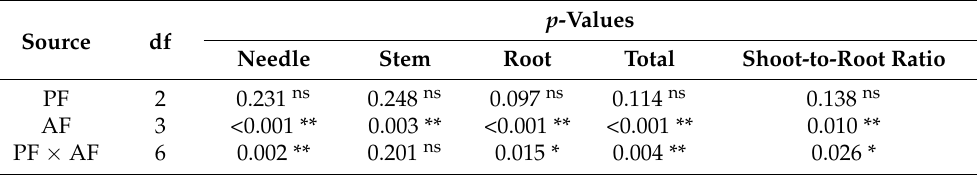
Table 2. Statistics (df, degrees of freedom; p -values; and significance levels) of two-way ANOVAs testing the main and interaction effects of pre-hardening fertilization type and autumn fertilization level on biomass allocation of Pinus koraiensis seedlings. p -Values Source df Needle Stem Root Total Shoot-to-Root Ratio PF 2 0.231 ns 0.248 ns 0.097 ns AF <0.001 **